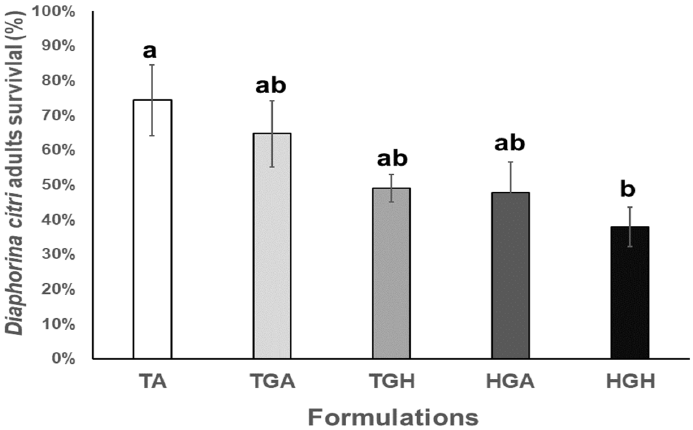
Figure 5. Diaphorina citri adults’ survival percentage average in laboratory bioassay after Hirsutella citriformis formulated conidia application by spraying. Absolute control = TA, Acacia gum control = TGA, Hirsutella gum control = TGH, formulation with Acacia gum = HGA, formulation with Hirsutella gum = HGH, . Different letters indicate significant statistical differences, and bars indicate the stand- ard error of the mean (Tukey test).